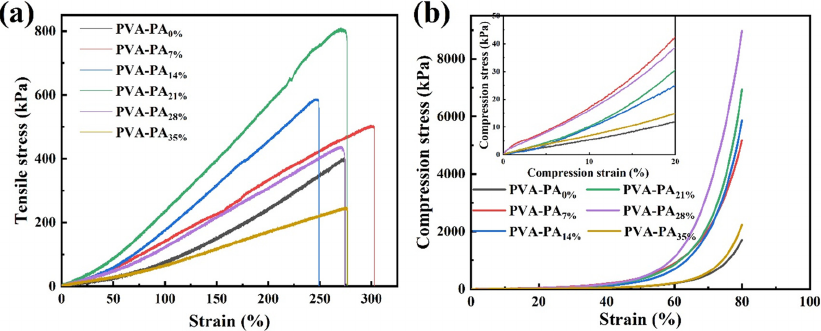
Figure 3. ( a ) Tensile stress-strain curve of PVA-PAX hydrogel. ( b ) Compressive stress-strain